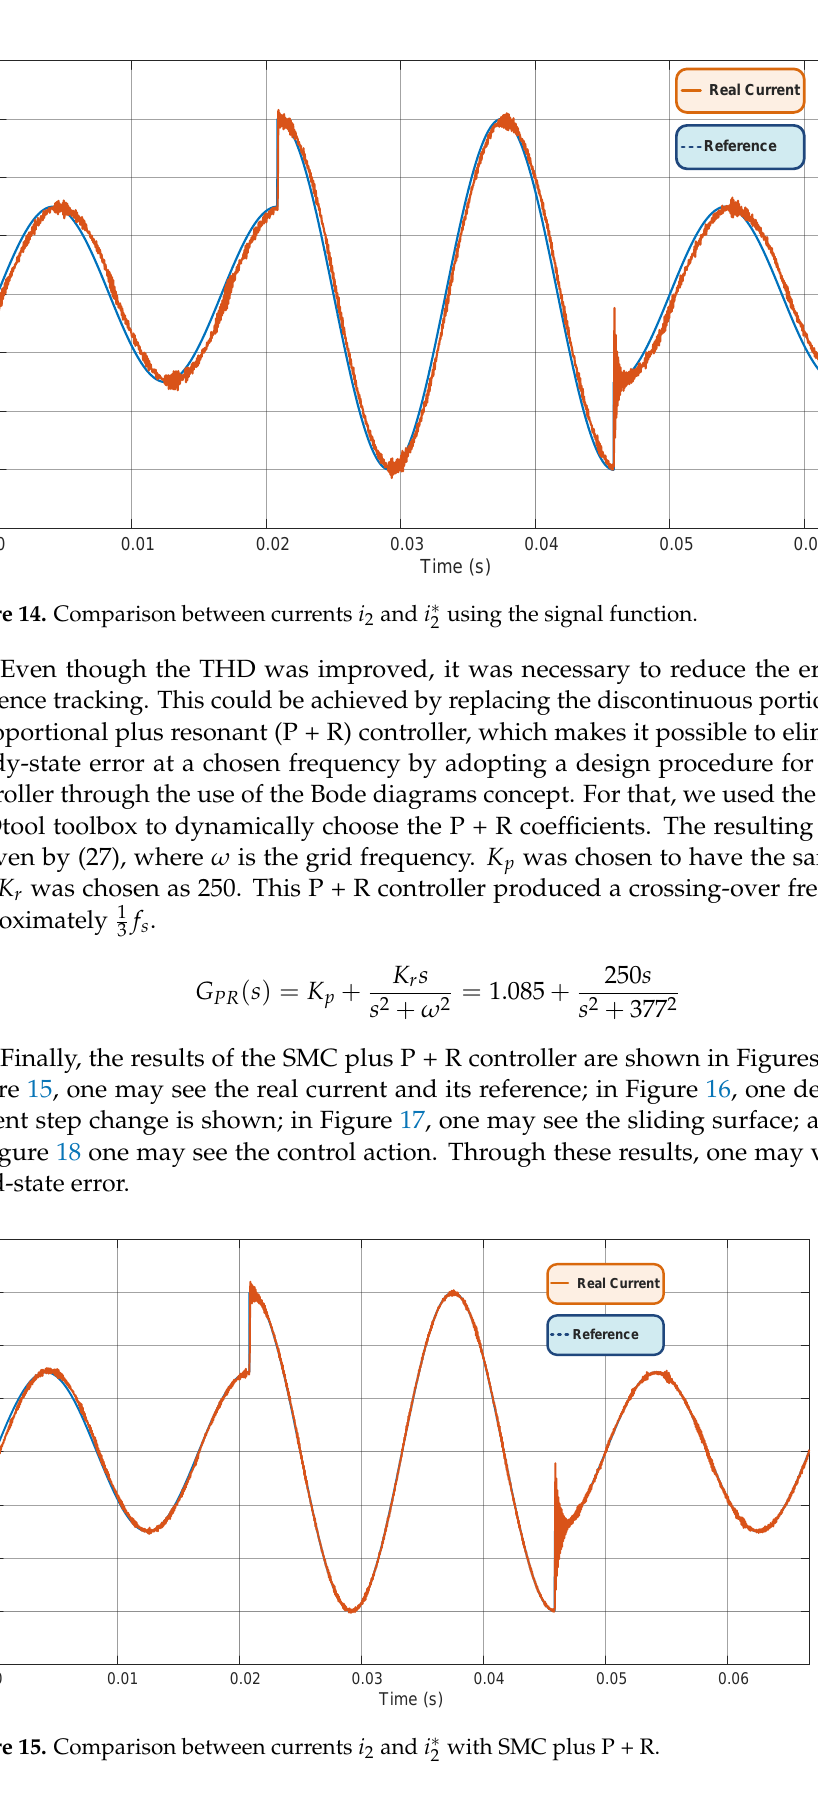
with SMC plus P + 2